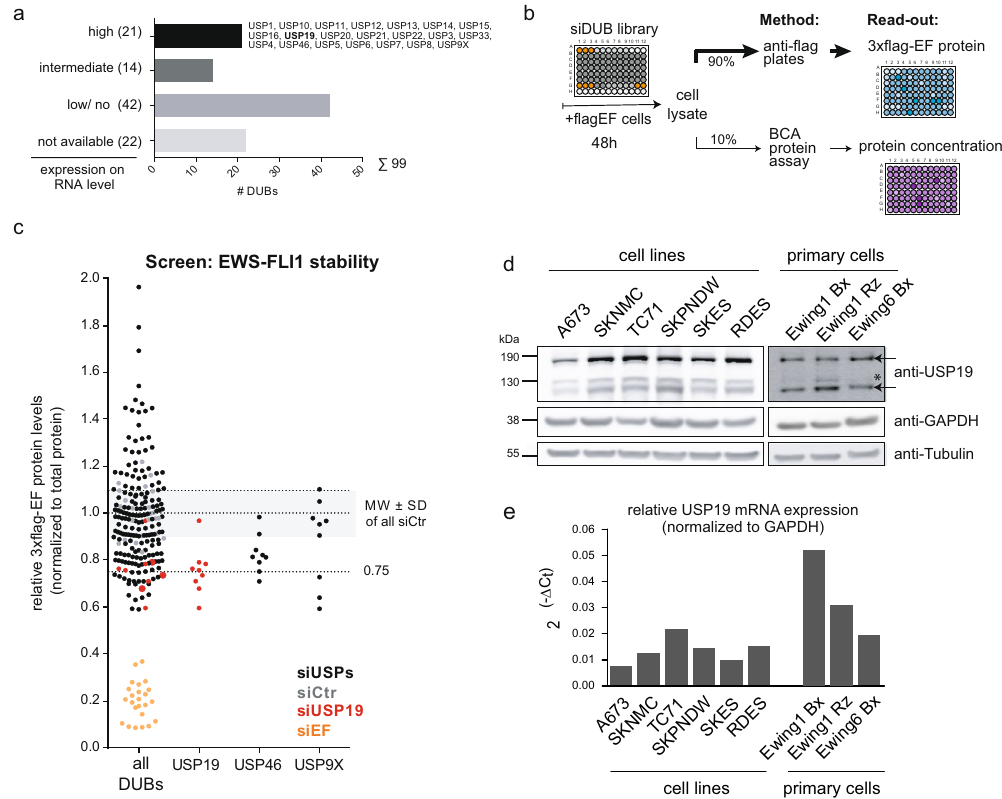
Figure 1. SiRNA screen identifies USP19 as a modulator of EWS-FLI1 stability. ( a ) In-silico selection of candidates. 21 deubiquitinating enzymes were selected based on their expression levels from publicly available microarray data sets of Ewing cell lines and tumors. ( b ) Screening setup. A673 and RDES cells stably expressing flag-tagged EWS-FLI1 were reverse transfected with single siRNAs from a small siRNA library. After 48 h, lysates were incubated in anti-flag coated plates to determine EWS-FLI1 protein normalized to total protein input. ( c ) EWS-FLI1 protein levels upon candidate knockdown. Each dot represents 3xflag-EWS-FLI1 protein levels normalized to its total protein for each single well. 3xflag-EWS-FLI1 levels upon USP19 knockdown are indicated with larger red dots and upon EWS-FLI1 knockdown in orange. ( d ) Expression levels of USP19 in indicated cell lines and primary samples were analyzed by western blot using USP19 antibody. The arrows indicate specific USP19 isoforms, asterisk marks unspecific band. ( e ) mRNA expression of USP19 was determined by quantitative RT-PCR from same cells and normalized to